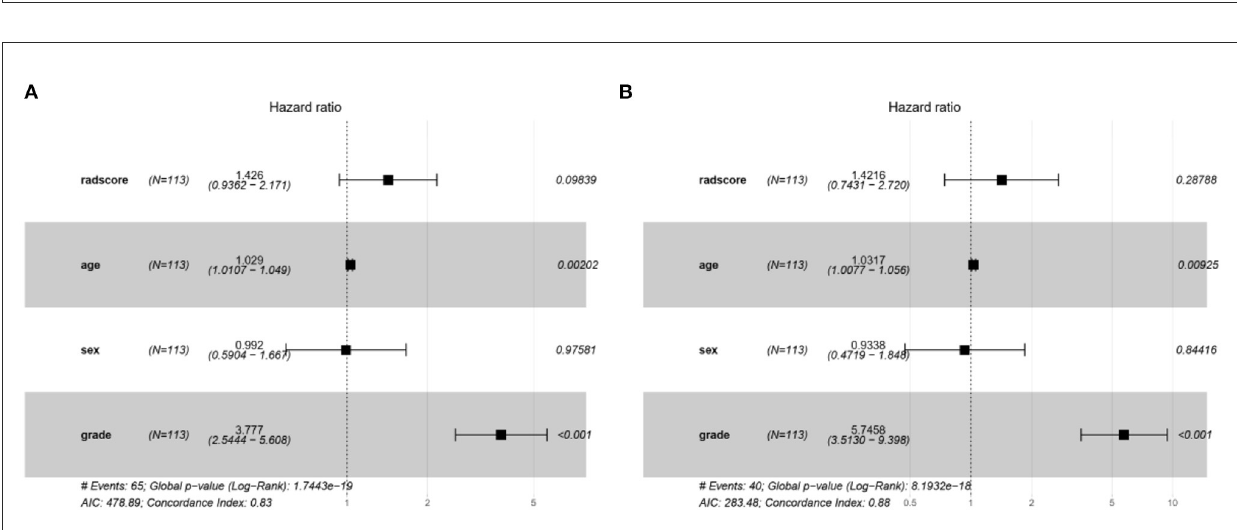
FIGURE6 The forest plots of characteristic risk scores to analyze the recurrence and survival outcome in the DL model. (A) Recurrence and (B)